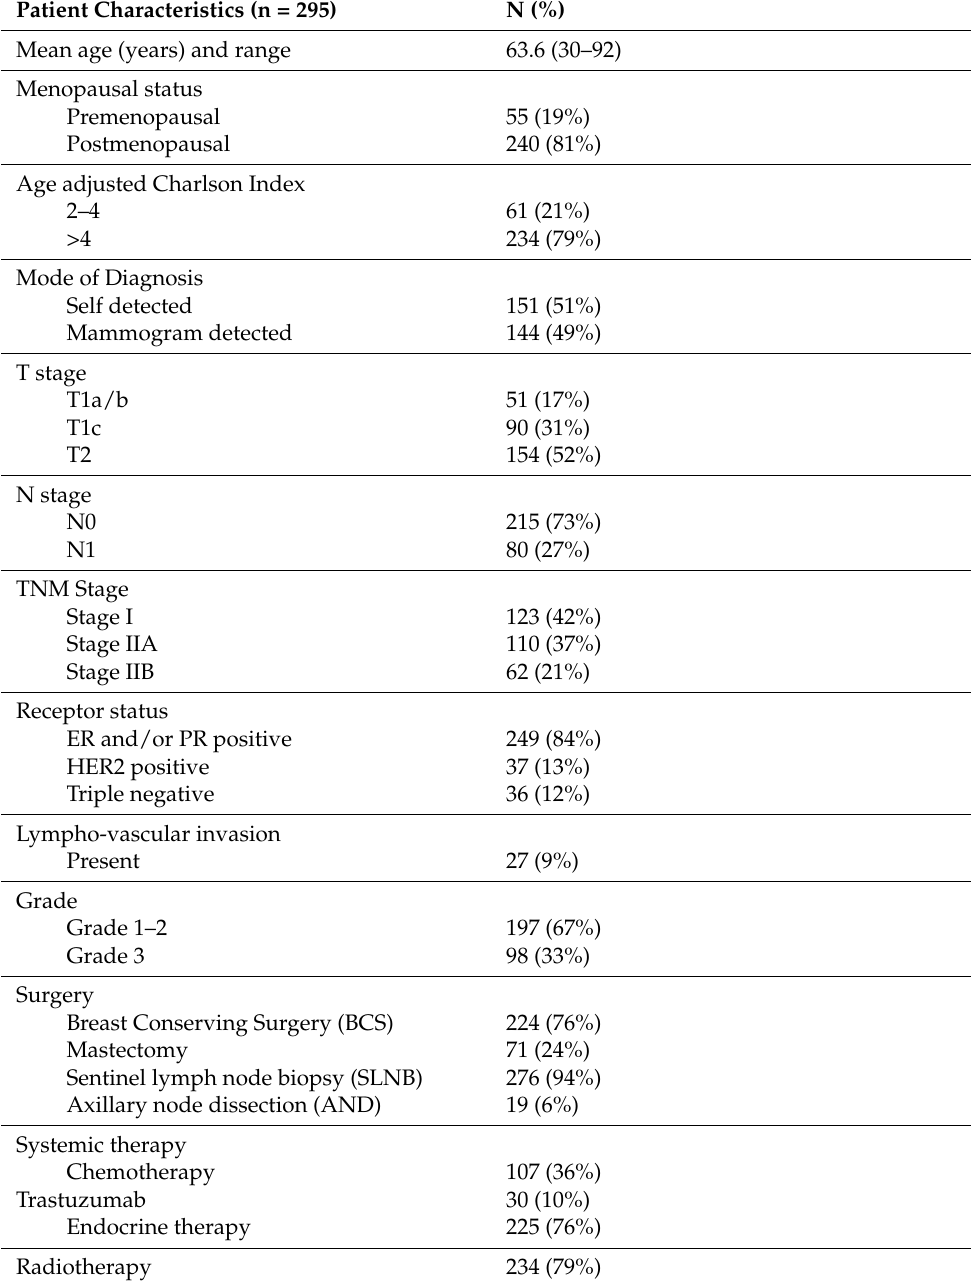
Table 1. Demographic and treatment characteristics of all eligible